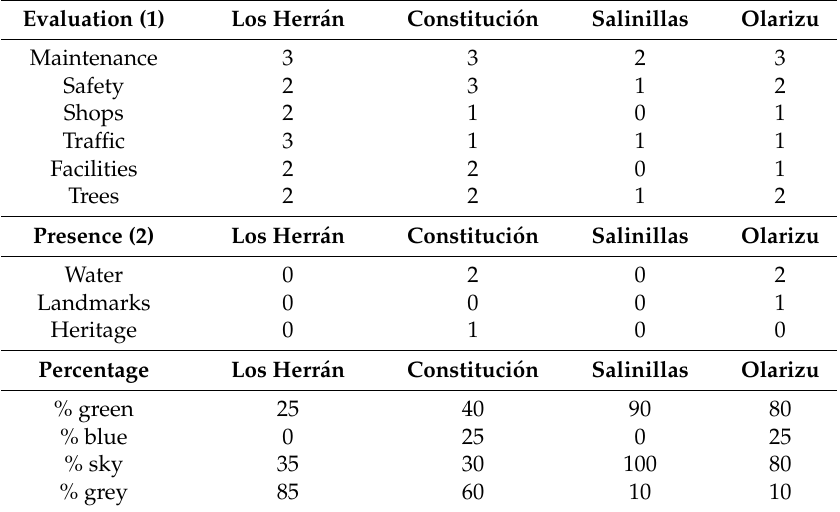
Table 1. Description of the four urban places